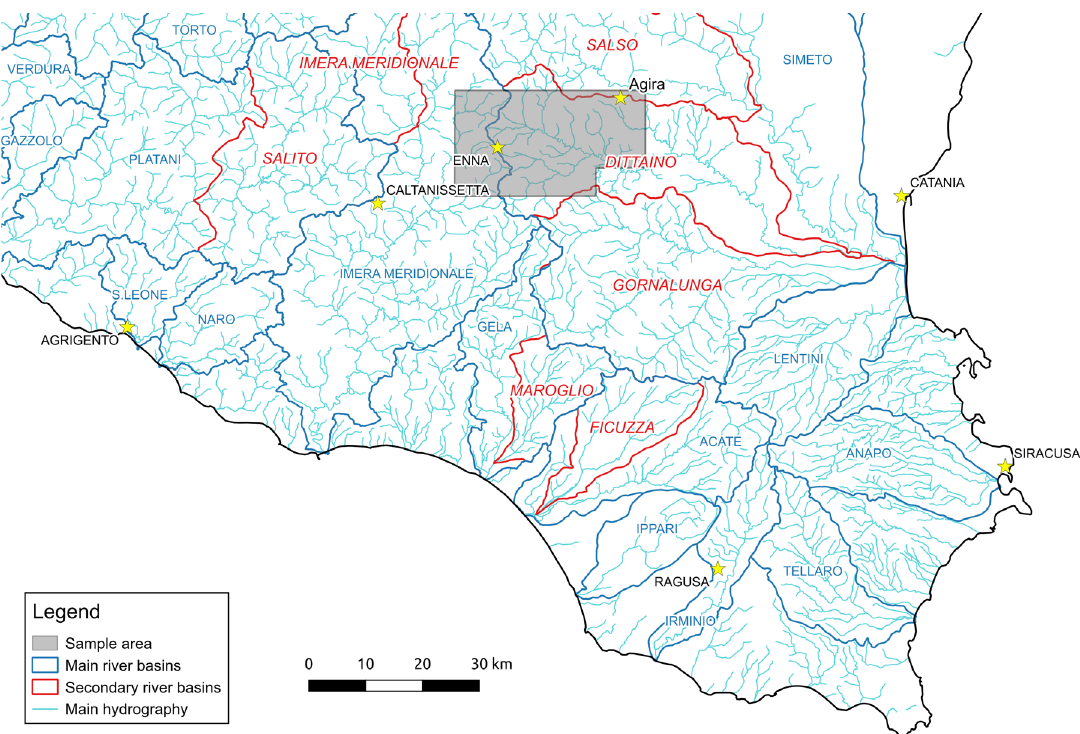
Fig. 1. Sicily and the selected area. Blue: main river basins, red: secondary